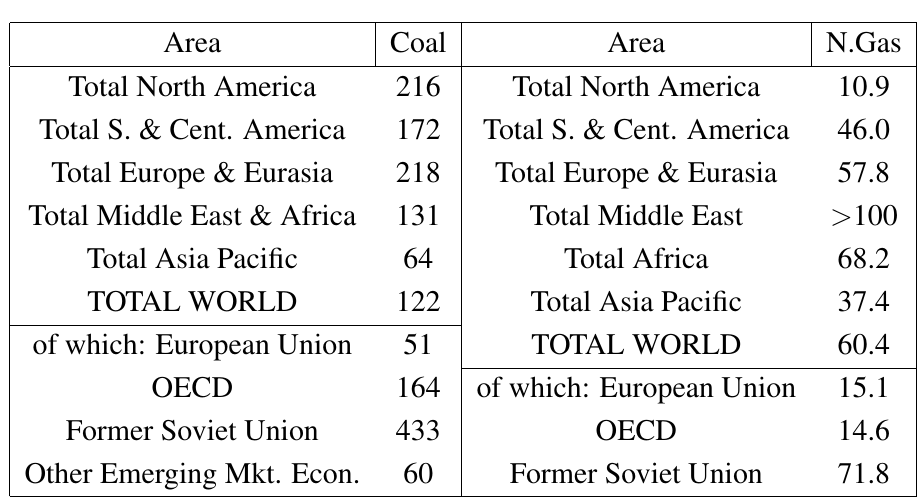
Table 3. Proven reserves to production ratio ( R/P ) at end of 2008.